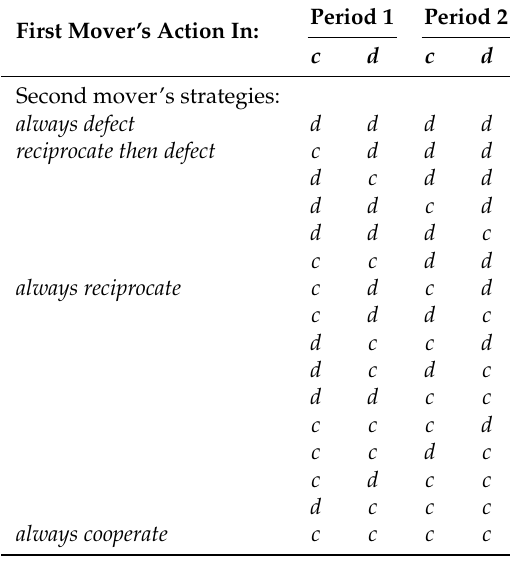
Table 1. Possible strategies of second